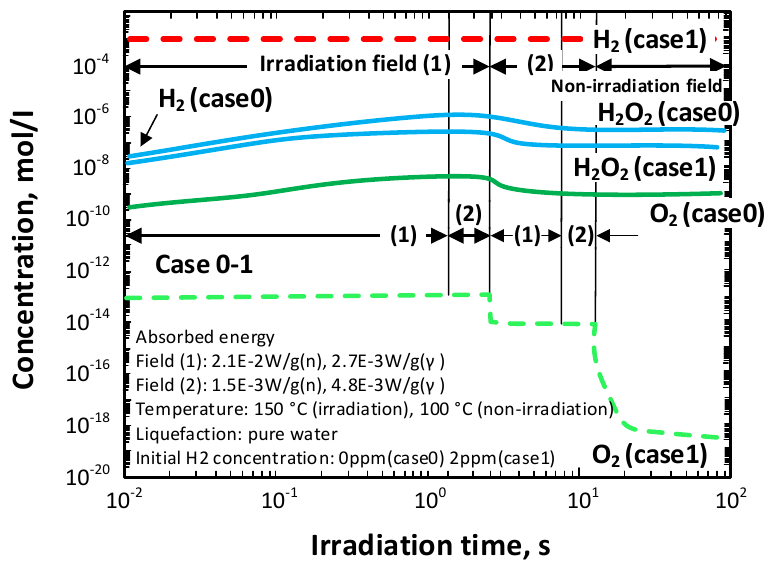
Figure 19. Predicted concentrations of radiolytic species in the ITER blanket PHTS cooling water without (Case 0) and with (Case 1) the addition of 2 ppm (1 × 10 −3 m) hydrogen (after Sato et al. [25]). © 2006 ITER Organization. This image is hereby used courtesy of the ITER Organization.